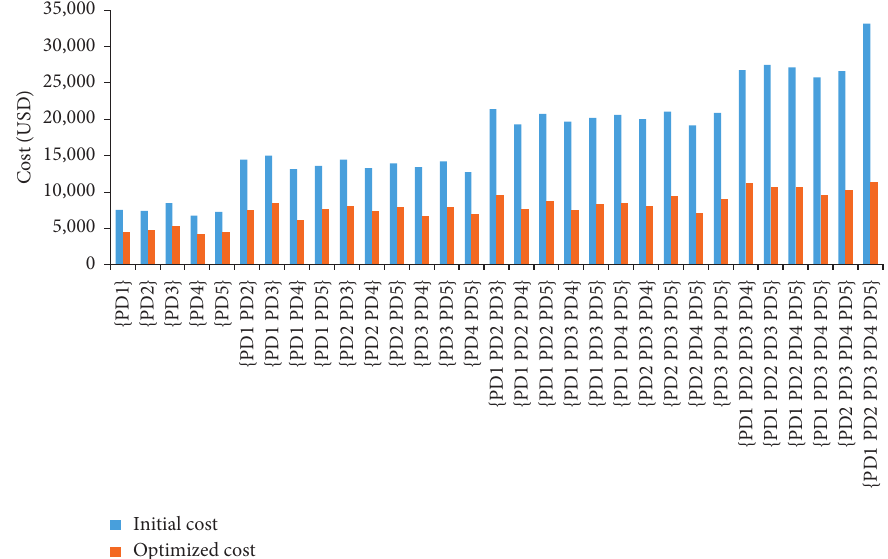
Figure 5: Comparison between initial and optimized networks cost solutions. Table 9: Comparison between initial delivery time and optimized delivery time (unit: